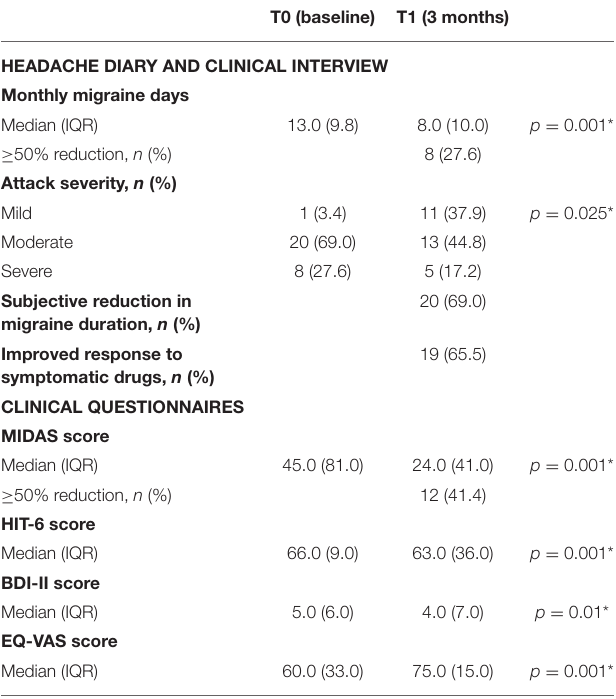
TABLE 3 | Erenumab effect on migraine after 3 months of treatment in enrolled patients ( n =